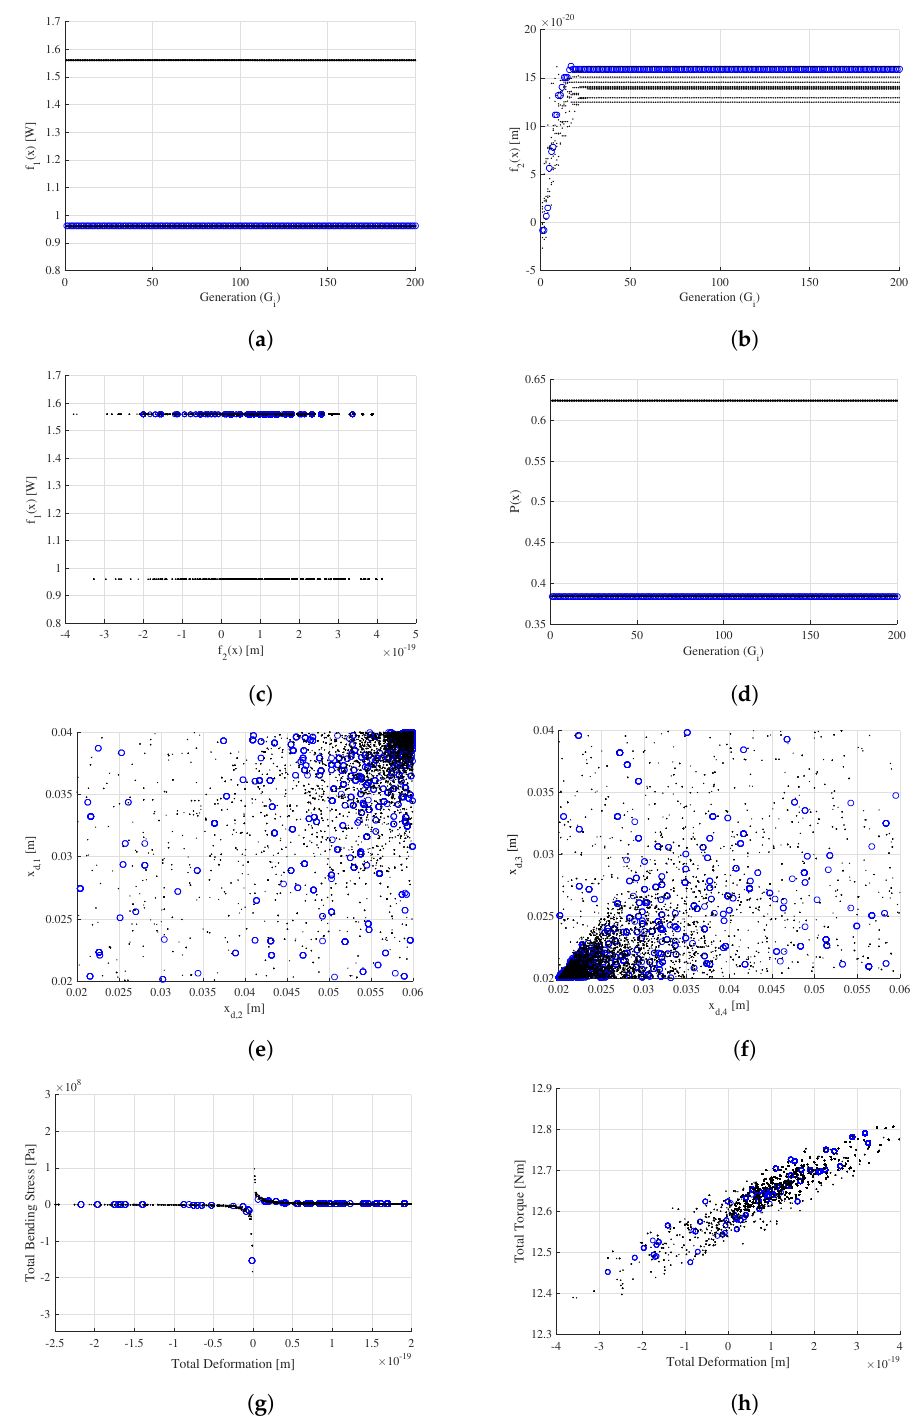
Figure 7. Optimization results of the ten best combinations; blue circles show the best values of the combination 116 for each generation. ( a ) Convergence of function f 1 ( ¯ x ) , ( b ) convergence of function f 1 ( ¯ x ) , ( c ) results of f 1 ( ¯ x ) and f 2 ( ¯ x ) , ( d ) convergence of performance function, ( e ) solution of design variables x d ,1 and x d ,2 , ( f ) solution of design variables x d ,3 and x d ,4 , ( g ) results of total deformation and total bending stress, and ( h ) results of total deformation and total